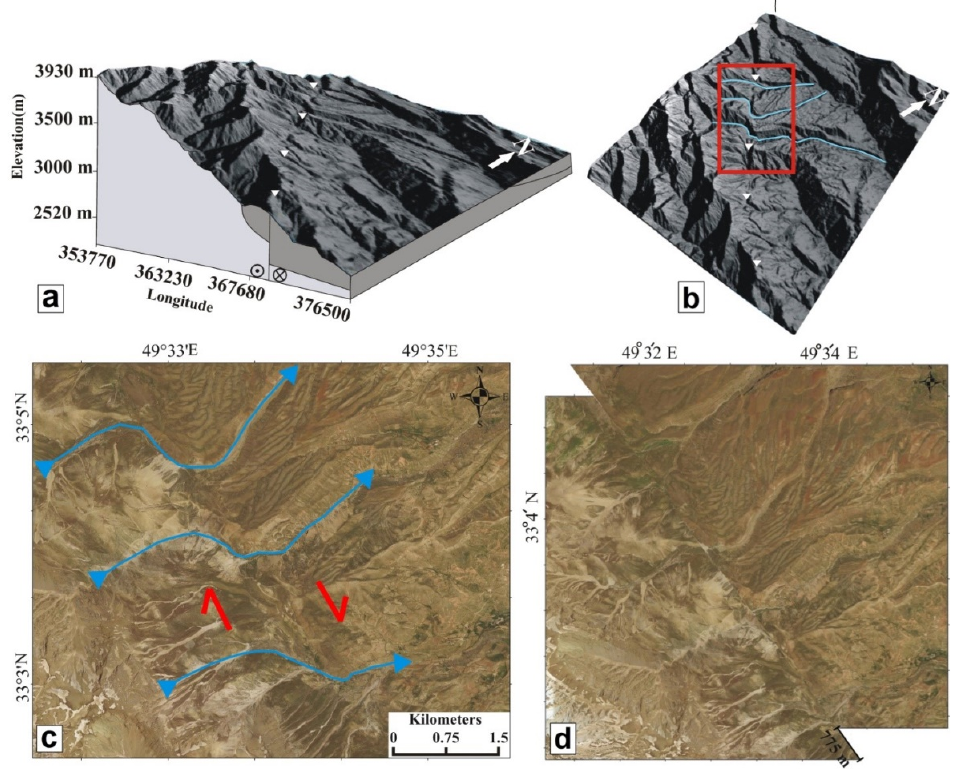
Figure 5. Offset reconstruction and morpho-structural interpretation: ( a ) The 3D perspective diagram (vertical exaggeration = 2) of the SE area (see Figure 2 for the location). Digital elevation model extracted from Aster 15 m. In this area, the Doroud Fault trace located between Quaternary alluvial and Pliocene piedmont deposits. ( b ) The present-day situation with three drainages and fault. The red box indicates the location of the ( c ). ( c ) Google Earth image of the right-lateral horizontal offsets of three rivers. The blue and red arrows indicate the rivers and right-lateral fault mechanism, respectively. ( d ) Reconstruction of the rivers to their initial position after back-slip the fault on the SASPlanet image of ~775 m of the rivers (1 and 2) offsets along the fault trace.